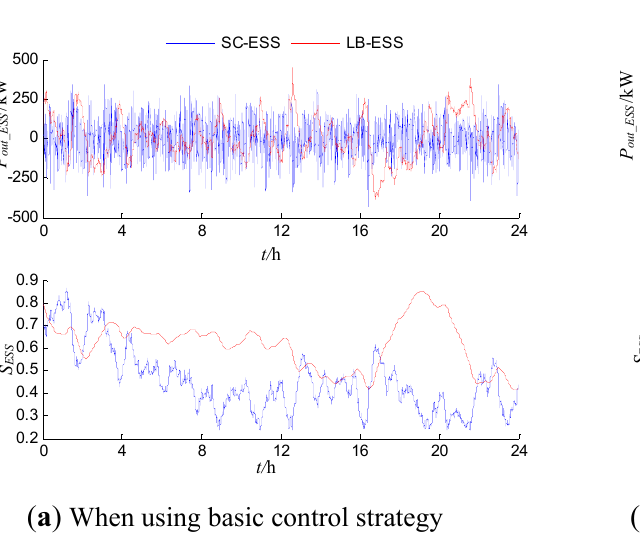
Figure 8. Output power and SOC of two ESSs using two strategies when T f =